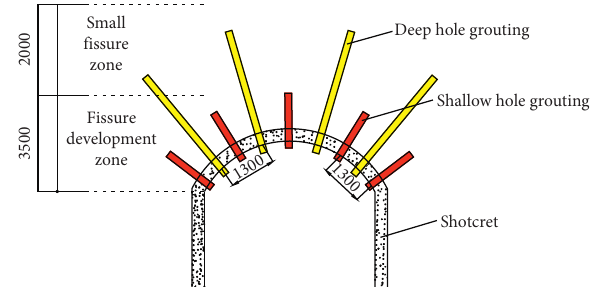
Figure 13: Schematic diagram of grouting hole design (unit: